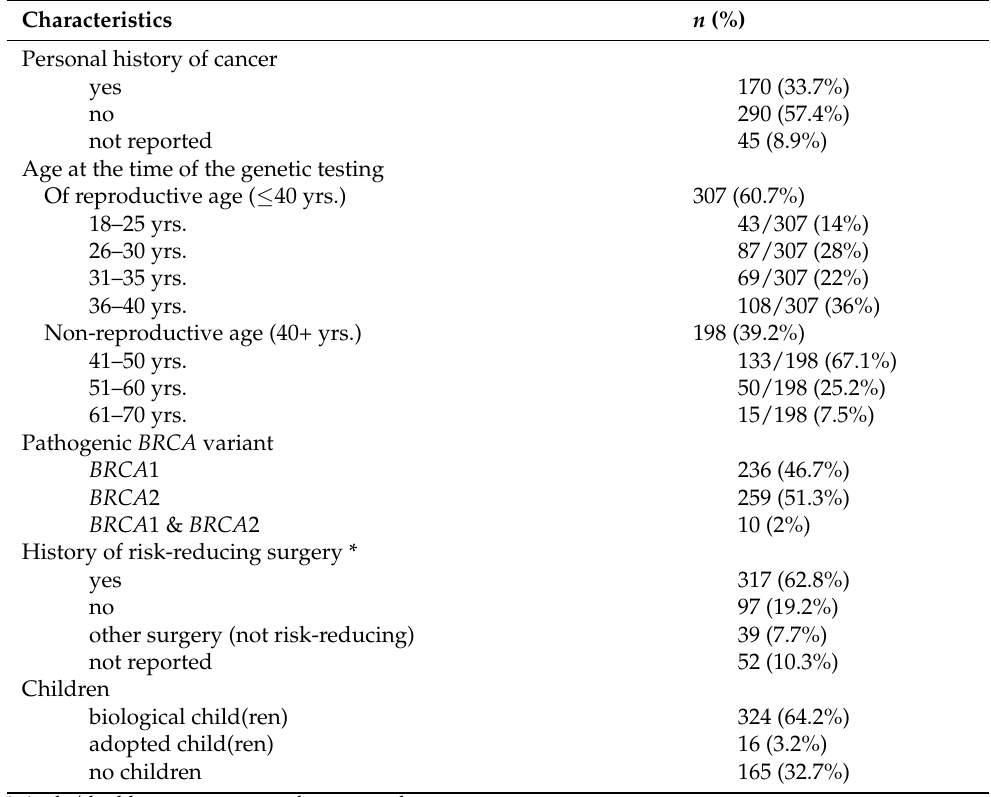
Table 2. Clinical and reproductive characteristics of BRCA+ women ( n =